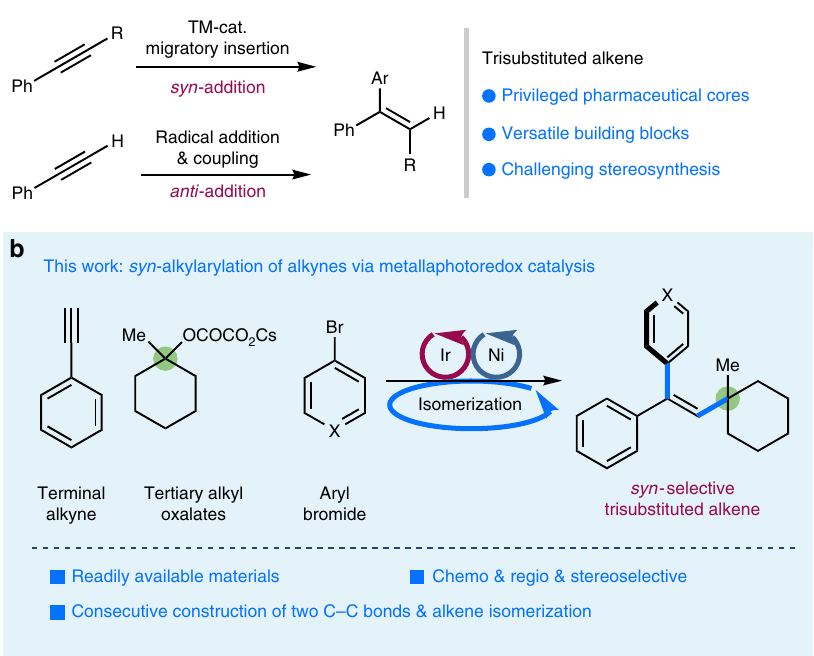
Fig. 1 syn -Alkylarylation of terminal alkynes via the combination of photoredox and nickel catalysis. a Alkyne functionalizations via transition metal catalysis. b syn -Alkylarylation of alkynes via metallaphotoredox